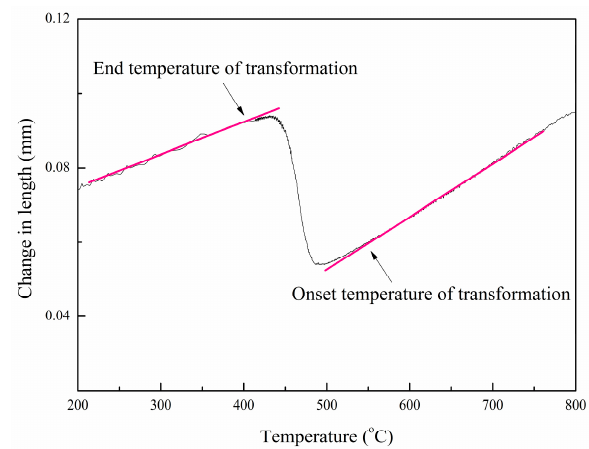
Figure 3. The tangent method used to determine the transformation temperature.